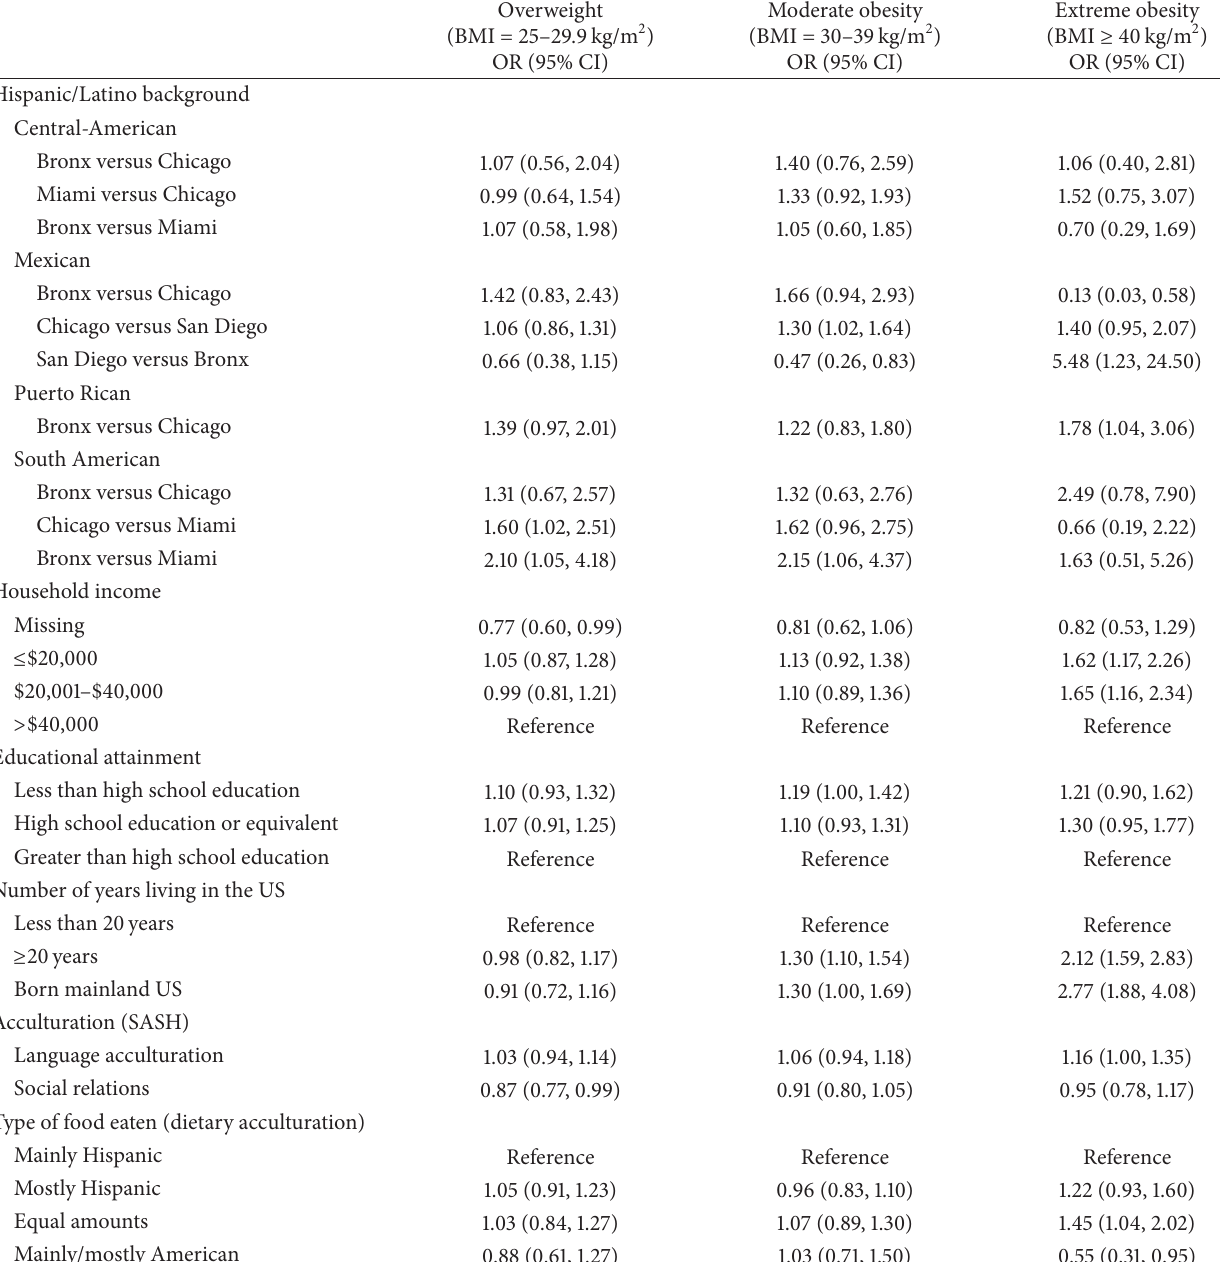
Table 1: Adjusted odds ratio (OR) ∗ for the association of moderate and extreme obesity with Hispanic background, sociodemographic variables, and